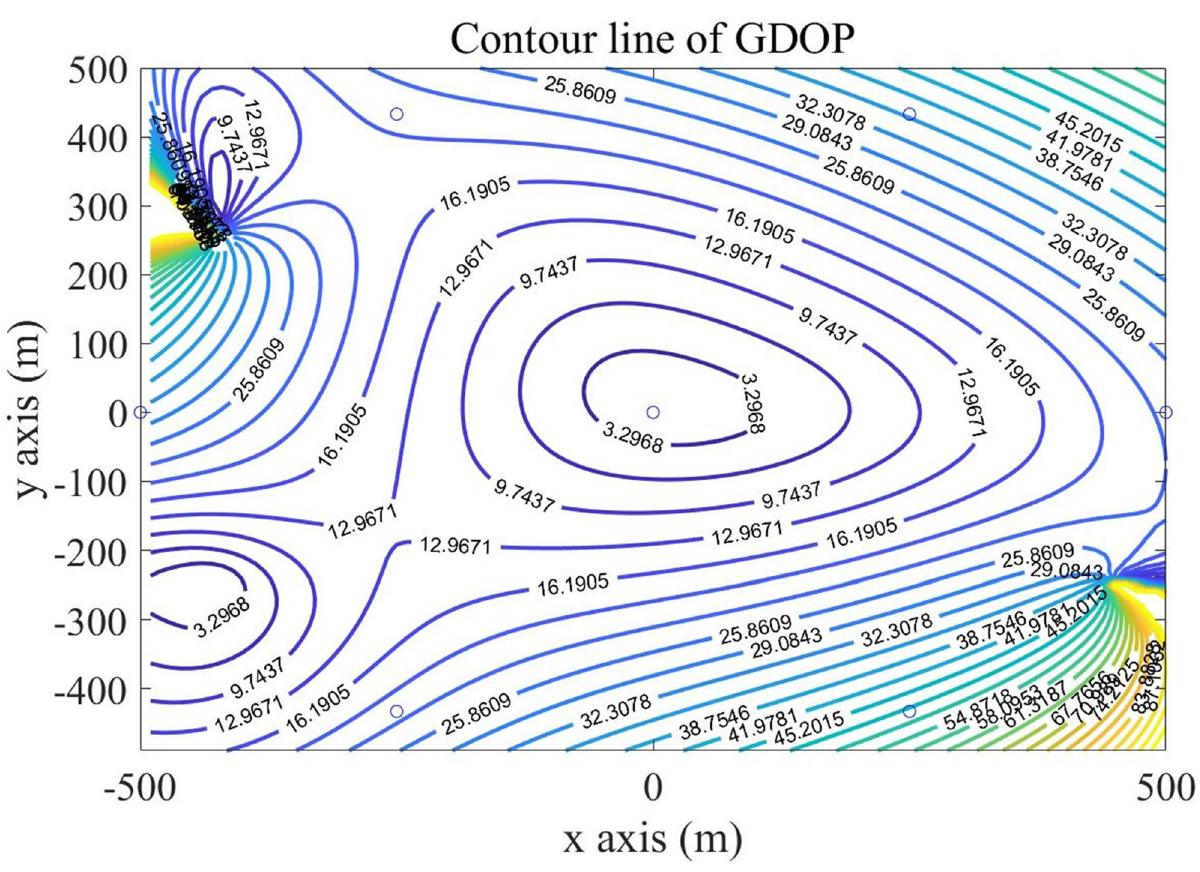
Fig 13. Contour line of GDOP in triangle layout.